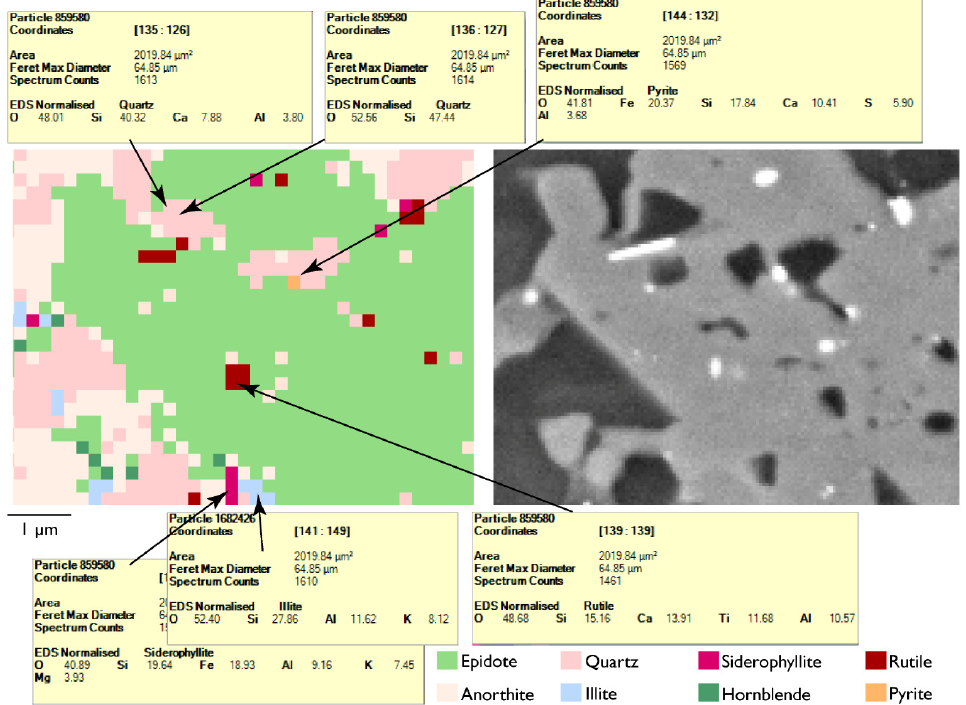
Figure 4. Detailed view of a false-colored mineral map and the associated BSE image. Each pixel represents 200 × 200 nm. Grains of ca. 200 nm can be recognized and classified from the energy-dispersivespectroscopy(EDX)dataforthatpixel. YellowboxesdisplayexampleEDXnormalized weight percentages and the interpretation of the operator for the